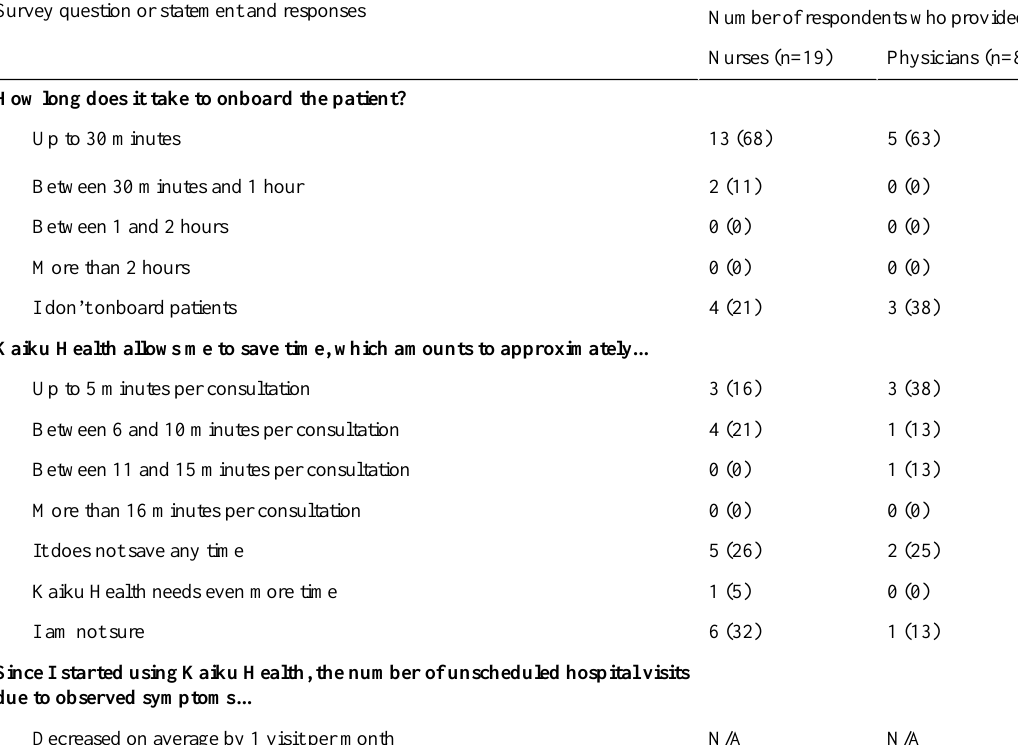
Patients (n=21)Physicians (n=8)Nurses (n=19)